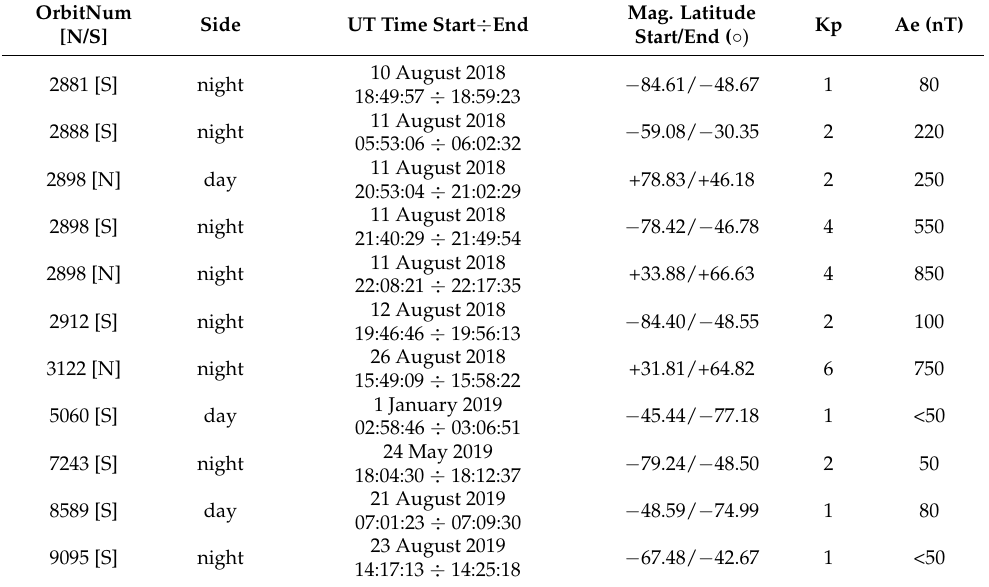
Table 1. Table of the CSES-01 data shown in this work. The table reports, from left to right, the orbit number and the hemisphere (Northern [N] and Southern [S]), the side of the ionosphere analysed, the time interval considered for the analysis, the corresponding magnetic latitude (in AACGM coordinates), and the Kp and Ae indices (obtained from https://www.spaceweatherlive.com/en/